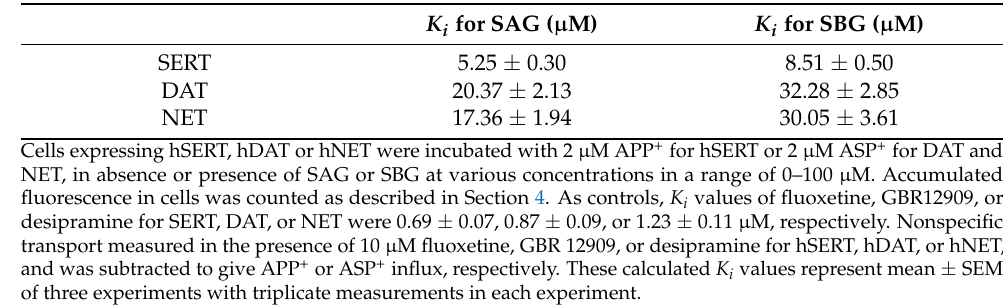
Figure 3. Inhibition of APP + transport by SAG and SBG. ( A ) Inhibition of APP + influx by SAG and SBG. APP + influx into the cells expressing hSERT measured as described under Section 4 using 2 μ M APP + in the presence of indicated concentrations of SAG ( ● ) or SBG ( ○ ). Control APP + influx rate in inhibitor absence was 7.82 ± 1.12 pmol/min/mg. Nonspecific uptake measured in the presence of 10 μ M fluoxetine and subtracted to give values of APP + influx. Graph shows representative experiment, with APP + influx expressed as a percentage of that measured in inhibitor absence. All error bars represent SDs from triplicate measurements. Experiment was repeated twice more with similar results. K i values for SAG and SBG were 5.25 ± 0.30 and 8.51 ± 0.50 μ M, respectively. These calculated K i values represent mean ± SEM of three experiments with triplicate measurements in each experiment. ( B ) Noncompetitive inhibition of APP + transport by SAG or SBG. APP + influx into the cells expressing hSERT was measured as described under Section 4 using indicated concentration of APP + in the absence ( ■ ) or presence of 5 μ M SAG ( ● ) or 8 μ M SBG ( ○ ). Nonspecific uptake measured in the presence of 10 μ M fluoxetine and subtracted to give shown values. Graph shows a representative experiment. All error bars represent SDs from triplicate measurements. The experiment was repeated twice more with similar results. K m and V max values represent mean ± SEM of three experiments with triplicate measurements in each experiment.